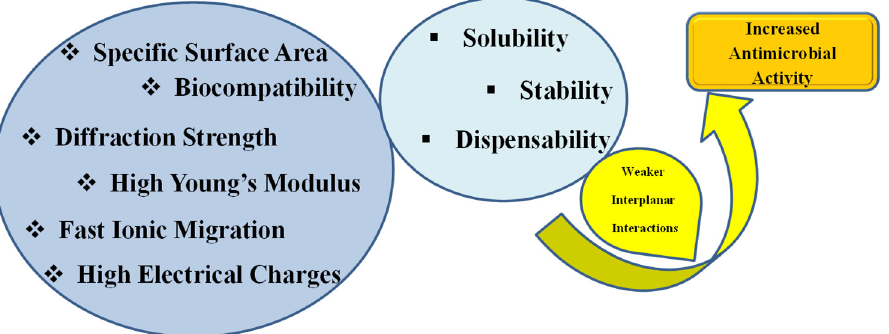
Figure 3. Properties of GN materials for antibacterial activities.